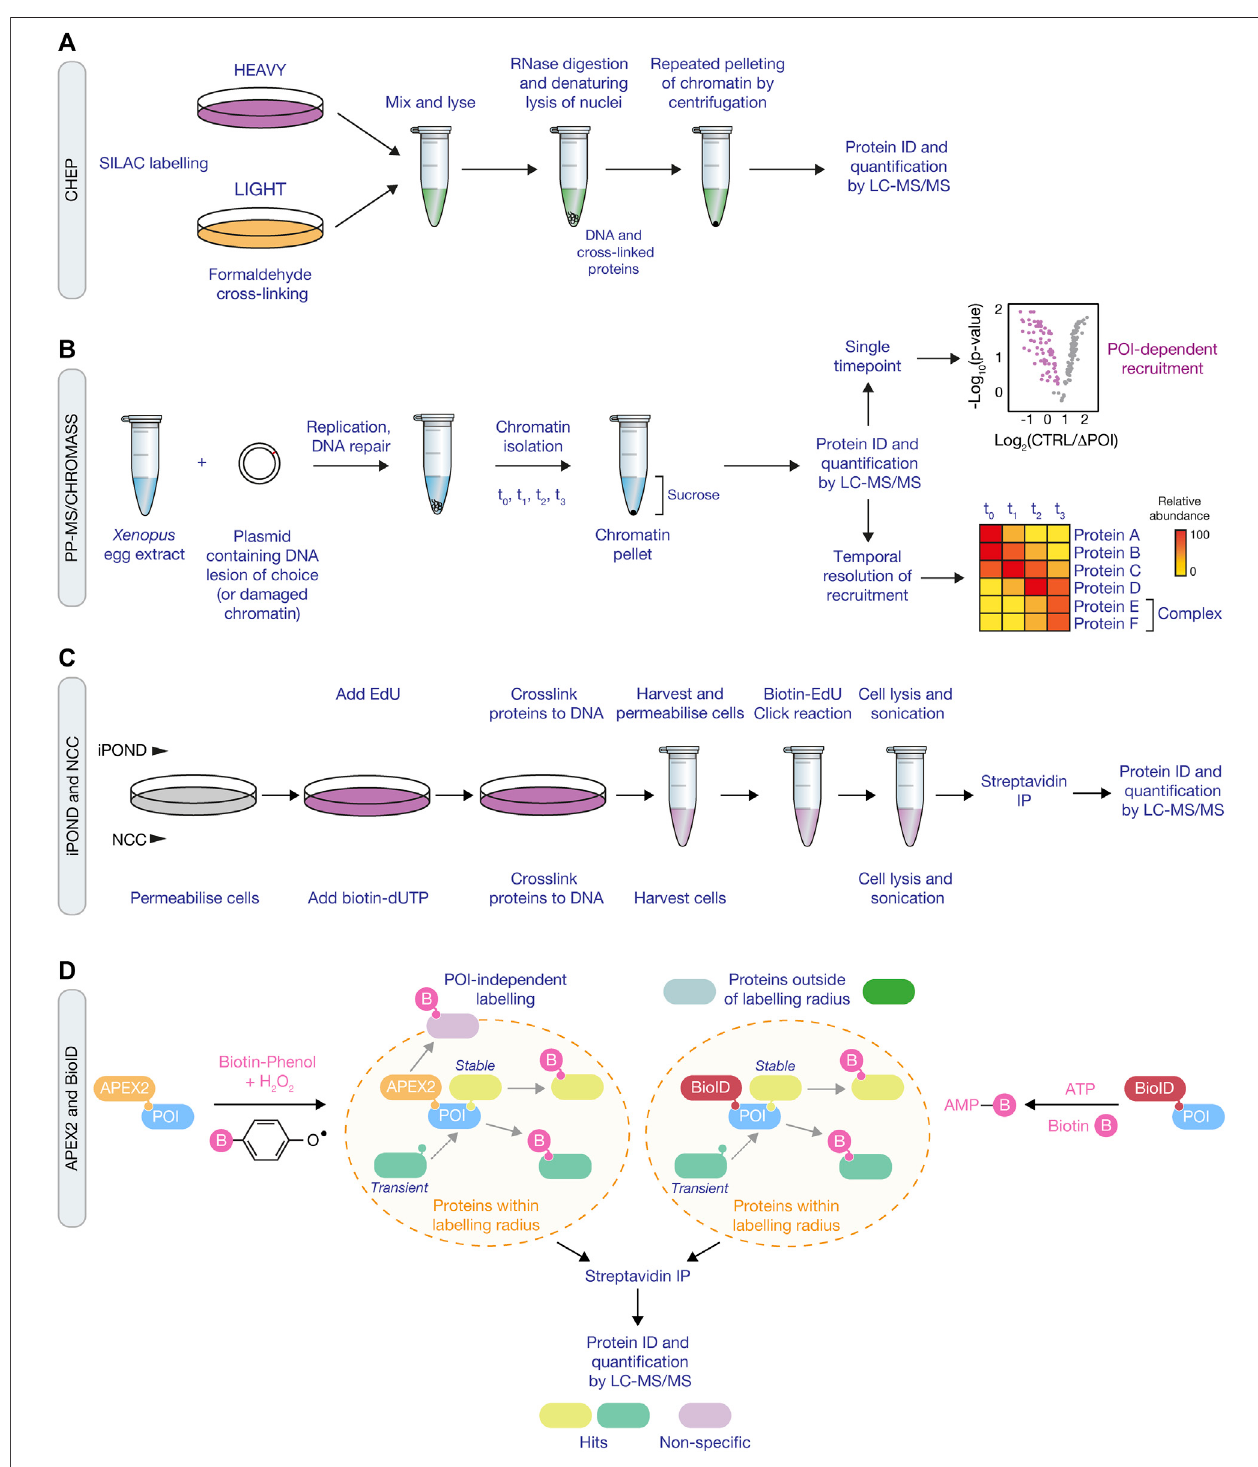
FIGURE 2 | Proteomic approaches for mapping the DDR network and ubiquitin signaling. (A) Schematic of the ChEP method, which requires isolation of cross- linked proteins from SILAC-labelled cells to isolate whole chromatin before analysis by LC-MS/MS. (B) Overview of the CHROMASS and PP-MS work fl ows in which damagedchromatinorplasmidswithasite-speci fi cDNAlesion,respectively,areincubatedwith Xenopus eggextracts,followedbyisolationandsubsequentanalysisby LC-MS/MS. (C) Comparison ofiPOND ( top ) and NCC ( bottom ) techniquesfor identifying factors associated with nascent DNA. iPOND utilises the incorporation of EdU followed by the Click reaction to conjugate biotin to EdU, whilst NCC uses incorporation of biotin-dUTP. (D) Schematic of APEX2 ( left ) and BioID ( right ) proximity